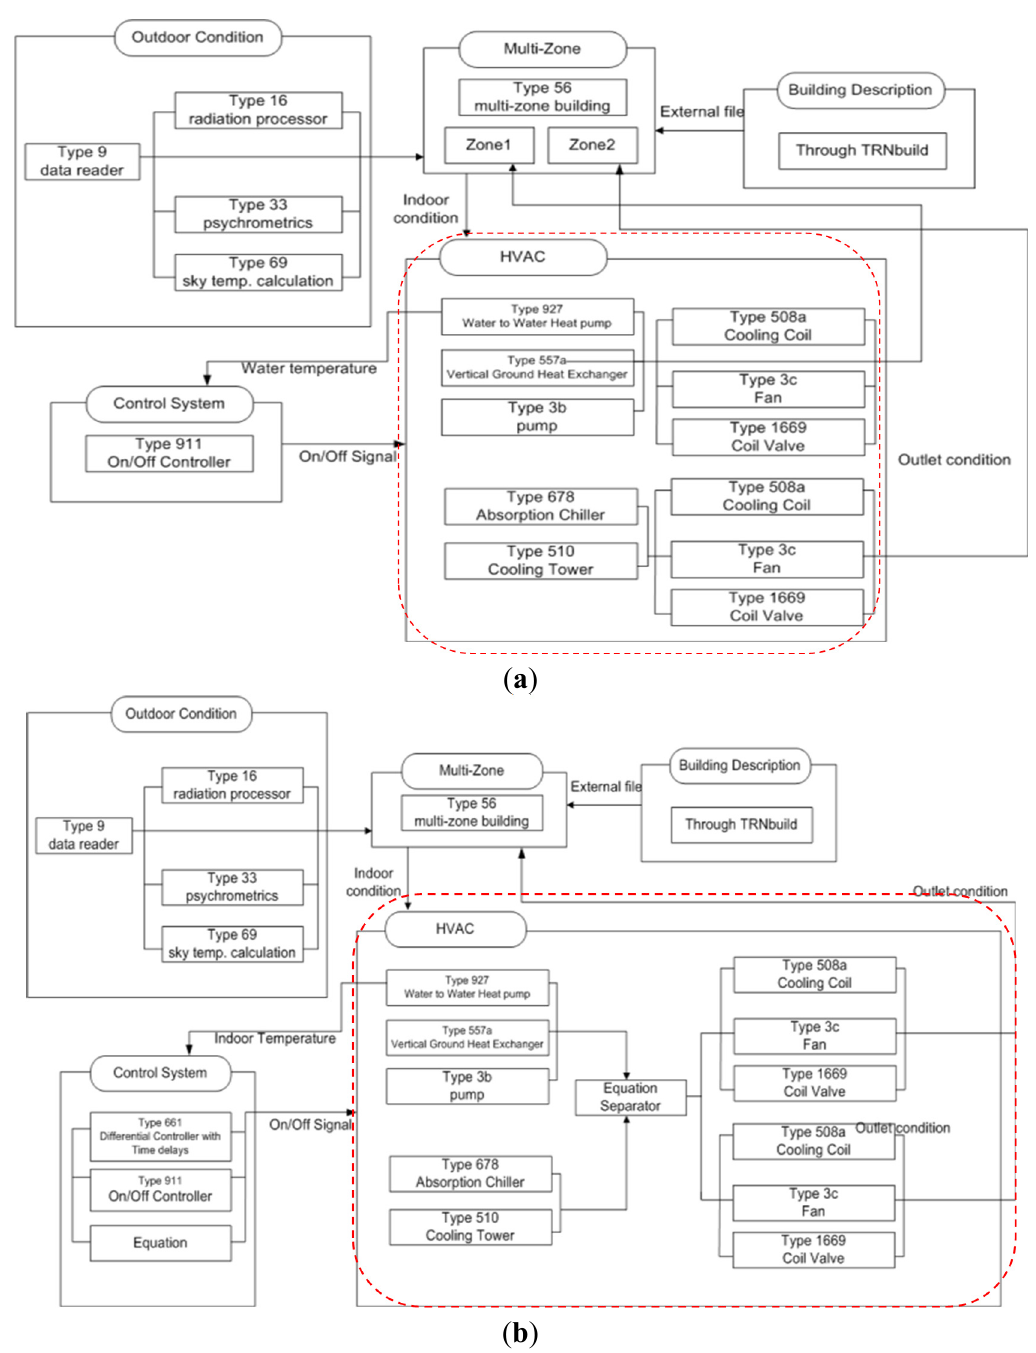
Figure 12. Simulation flow chart of a combination with the Multi-GHP system and an ABS chiller-heater system: ( a ) existing operation condition of the Multi-GHP system and ABS chiller-heater system (Case 2-1); ( b ) sequencing operation condition of the Multi-GHP system and ABS chiller-heater system (Case